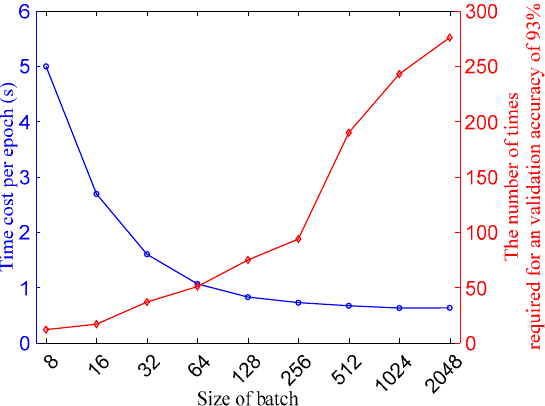
Figure 15. The effect of batch size on the calculation time cost of a single epoch and the speed of model learning.